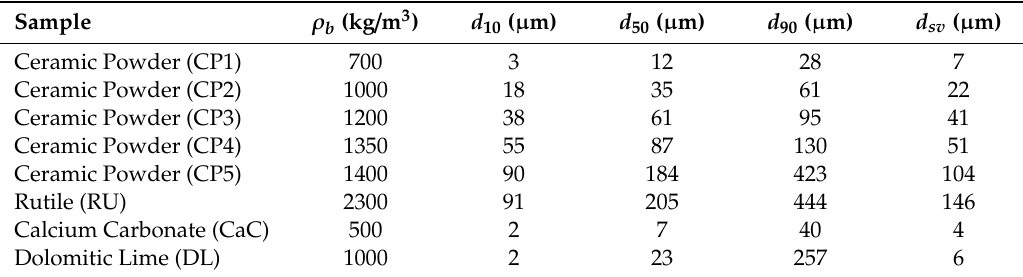
Table 1. Samples’ main